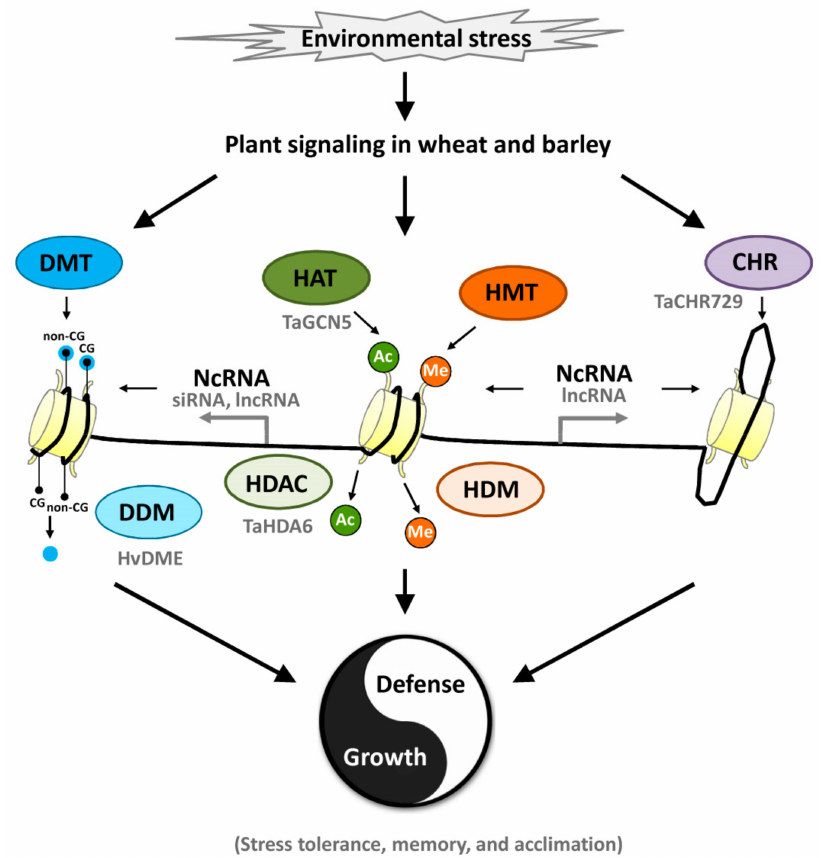
Figure 1. A general model for the role of epigenetic elements and processes in stress responses in wheat and barley. DNA methylation is regulated by DMT and DDM, while histone modifications include histone acetylation / deacetyaltion and methylation / demethylation mediated by HAT / HDAC and HMT / HDM enzymes. In addition, CHR-mediated chromatin remodeling and ncRNA-regulated epigenetic processes, including RdDM, histone modification as well as genome topology changes, also regulate gene expression in response to the environmental stresses. Ac, histone acetylation marker; Me, histone methylation marker; CHR, Chromatin remodeling complex / factor; DDM, DNA demethylase; DMT, DNA methyltransferase; HAT, histone acetyltransferase; HDAC, histone deacetylase; HDM, histone demethylase; HMT, histone methyltransferase; IncRNA, long non-coding RNA; NcRNA, non-coding RNA; RdDM, RNA-directed DNA methylation; siRNA, small interfering